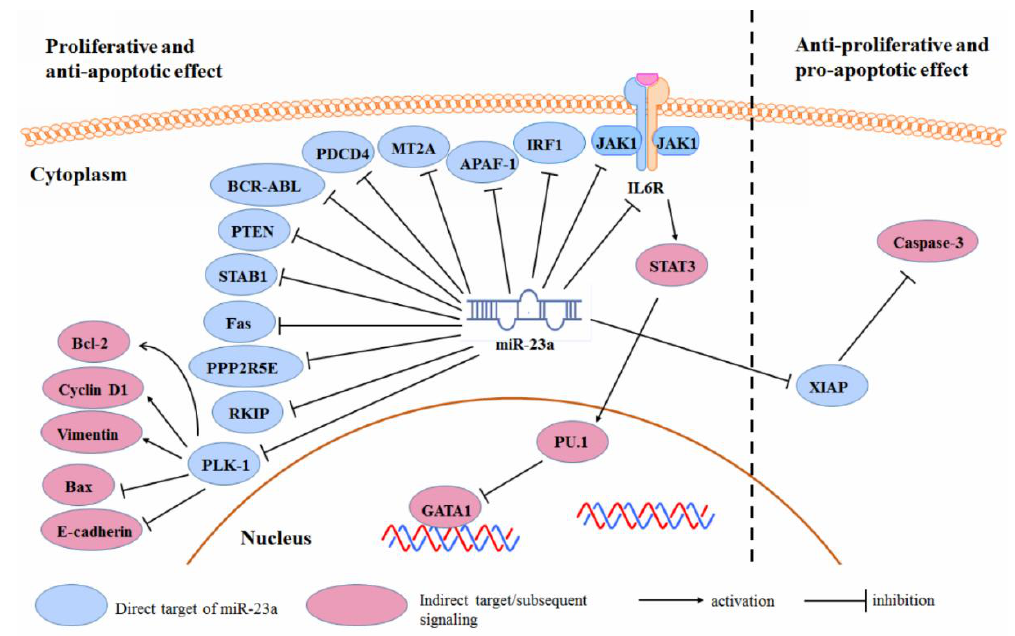
Figure 2. Regulation of the miR-23a on cancer cell proliferation and apoptosis.